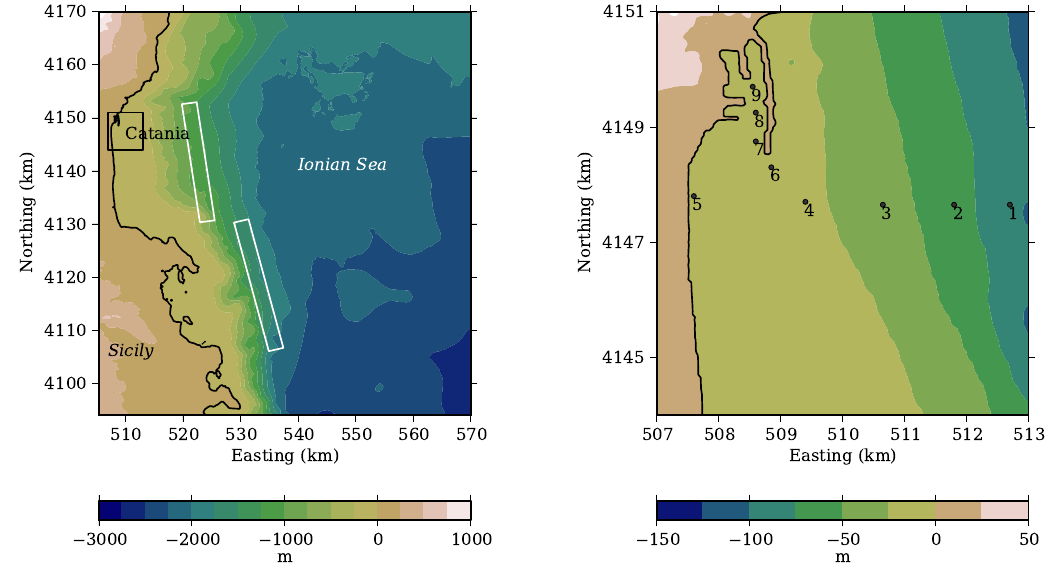
Fig. 20. The whole computational grid (on the left) and the zoom on the area of Catania and its beach called La Plaia to the south of the town (on the right). The two white rectangles represent the surface fault model projection. Here one also can see the position of 9 virtual tide gauges where tsunami records have been calculated. The harbour of Catania is formed by a long north–south jetty and by inner docks, which are accounted for in the grid. The most important docks are one built in the northern side, directed north–south; and two built on the western side, in the central part of the harbour, and directed east–west. Docks and jetty divide the harbour in an outer and two inner basins.